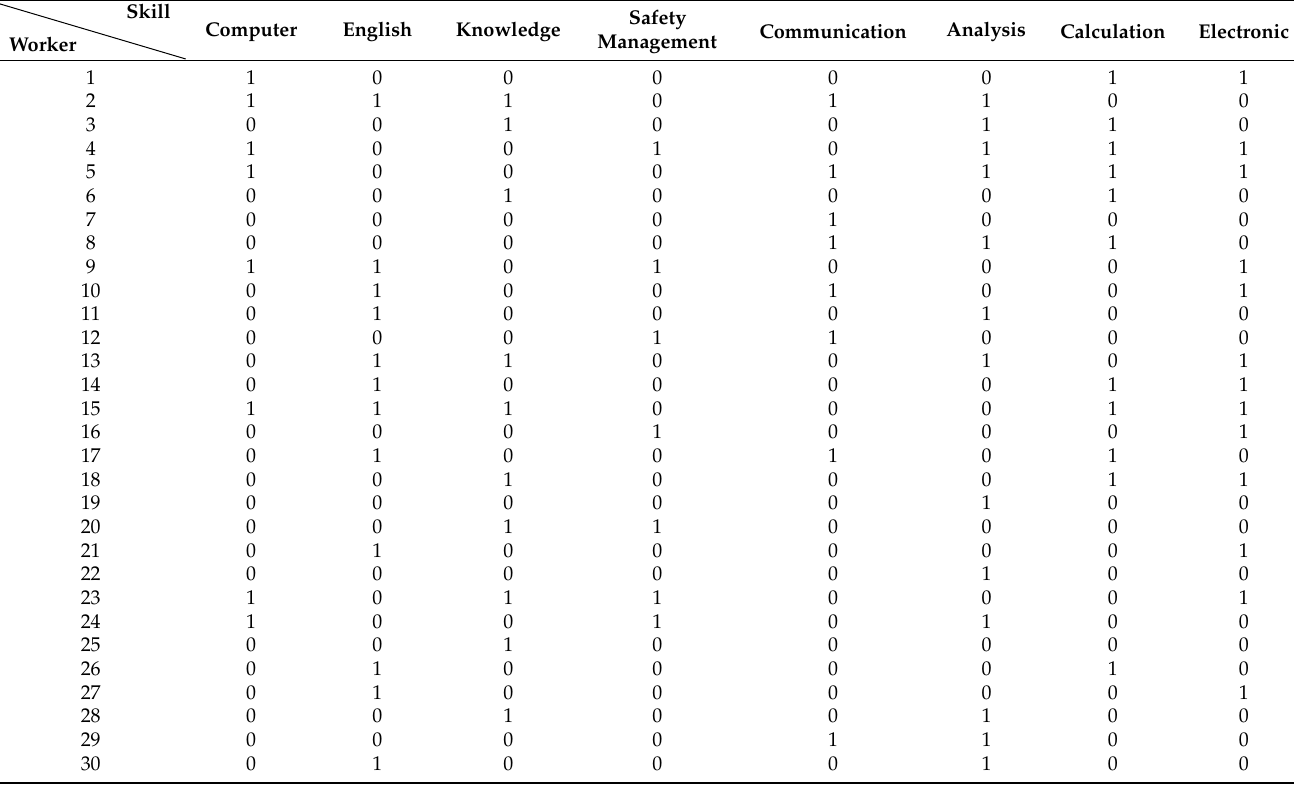
Table 4. Skills that workers provide.